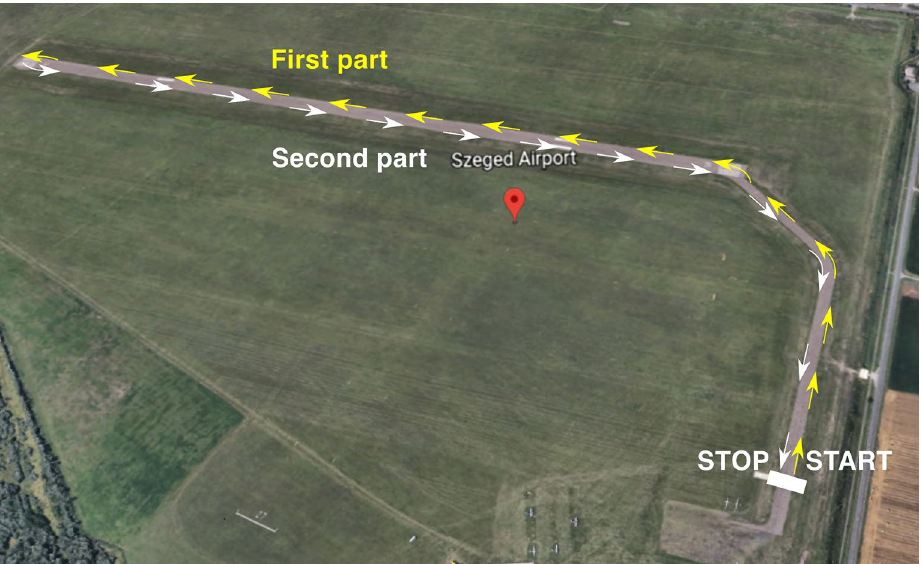
Figure 1. Birdseye view of the runway and the service road used in the experiment. Yellow arrows indicate the outbound path towards the end of the runway (First part), white arrows indicate the inbound path back to the starting position (Second part). Source: Google Earth (n.d.). [Google Earth map of Szeged Airport]. Retrieved June 10, 2022, from https:// earth. google. com/ web/@ 46. 24993 219,20. 09495 634,79. 94030 556a,1403. 84271 768d,35y,- 117. 93221 529h,45. 00445